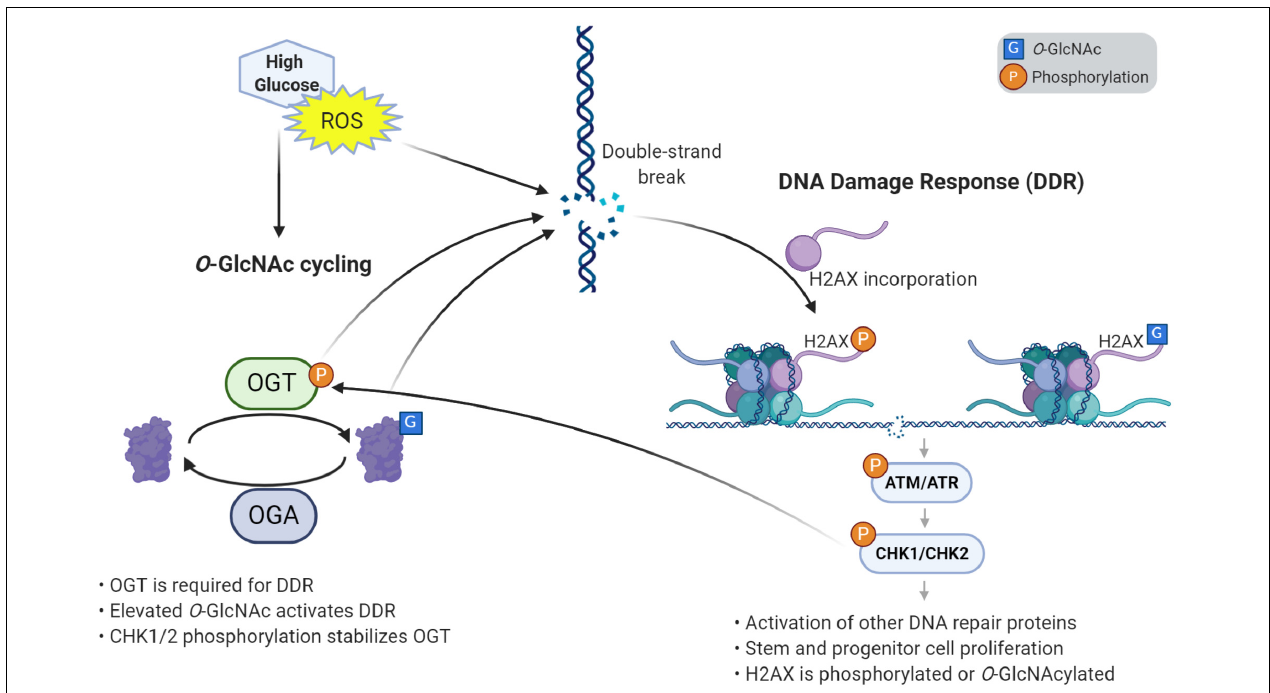
FIGURE 2 | O- GlcNAcylation induces the DNA damage response and proliferation in stem cells. High glucose and reactive oxygen species (ROS) cause damage to DNA such as double strand breaks. O- GlcNAcylation is required to respond to DNA damage, through its accumulation at damage sites and activation of the DNA damage response (DDR) pathway. Response to DNA damage also requires the incorporation of variant histone H2AX, which is phosphorylated and can also be O -GlcNAc modified. Elevated O- GlcNAc induces stem and progenitor cell proliferation and the DNA damage response through γ H2AX and a phosphorylation cascade of effector kinases. One of the downstream kinases, CHK1/2, phosphorylates OGT, which stabilizes the enzyme. This autoregulatory loop helps further promote the DNA damage response and